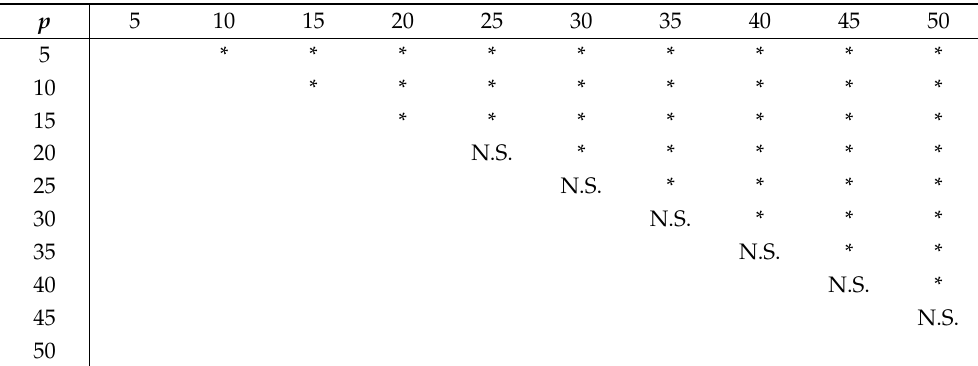
Table 9. Statistical significance in dryness perception for samples with a w value of 40 µ m for various p values. * Significance level < 0.05. N.S. means not significant.